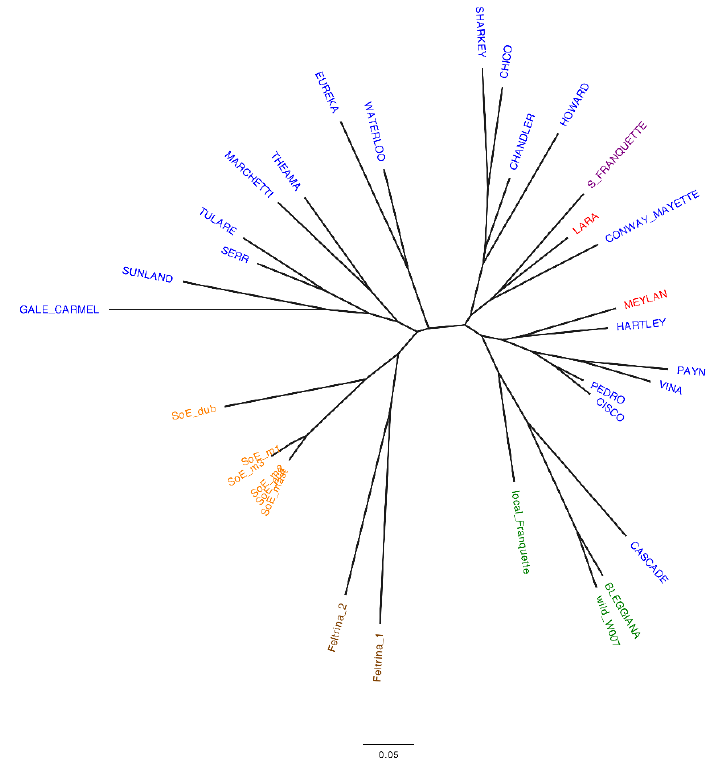
Figure 1. Unrooted neighbor-joining tree produced from Bruvo’s distance matrix estimated from SSR data. Labels are colored according to the geographical origin: green = northeastern Italy—Trentino; brown = northeastern Italy—Veneto; orange = south Italy—Campania; red = France; blue = USA; violet =